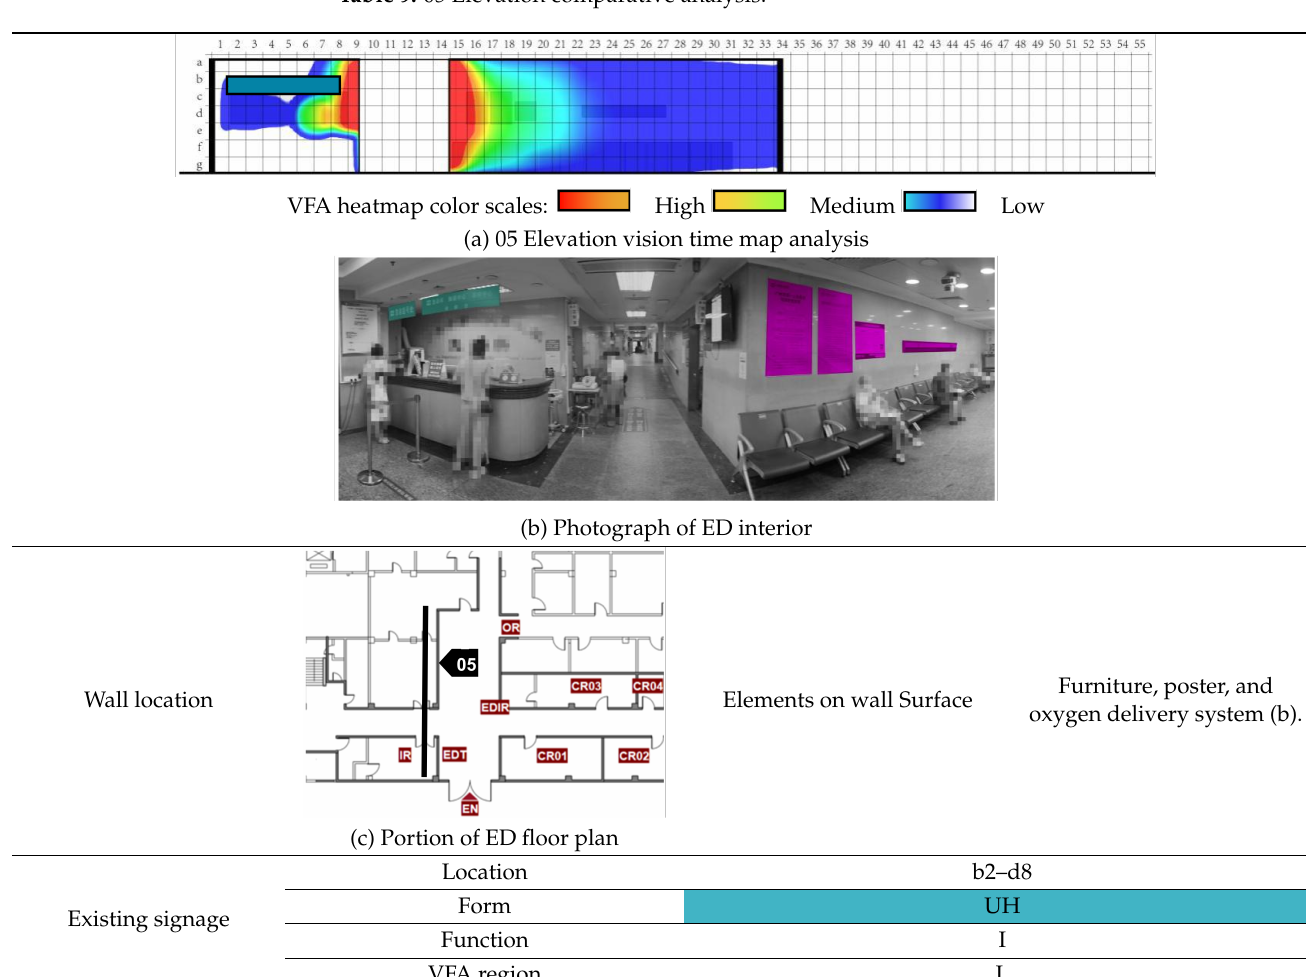
Table 9. 05 Elevation comparative